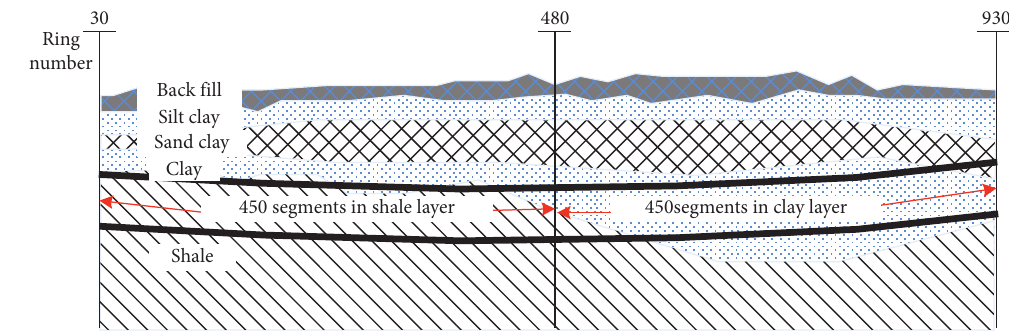
Figure 1: Field test position of segment lift on two different soil layers. Table 1: Physical and mechanical ground characteristics around the tunnel.